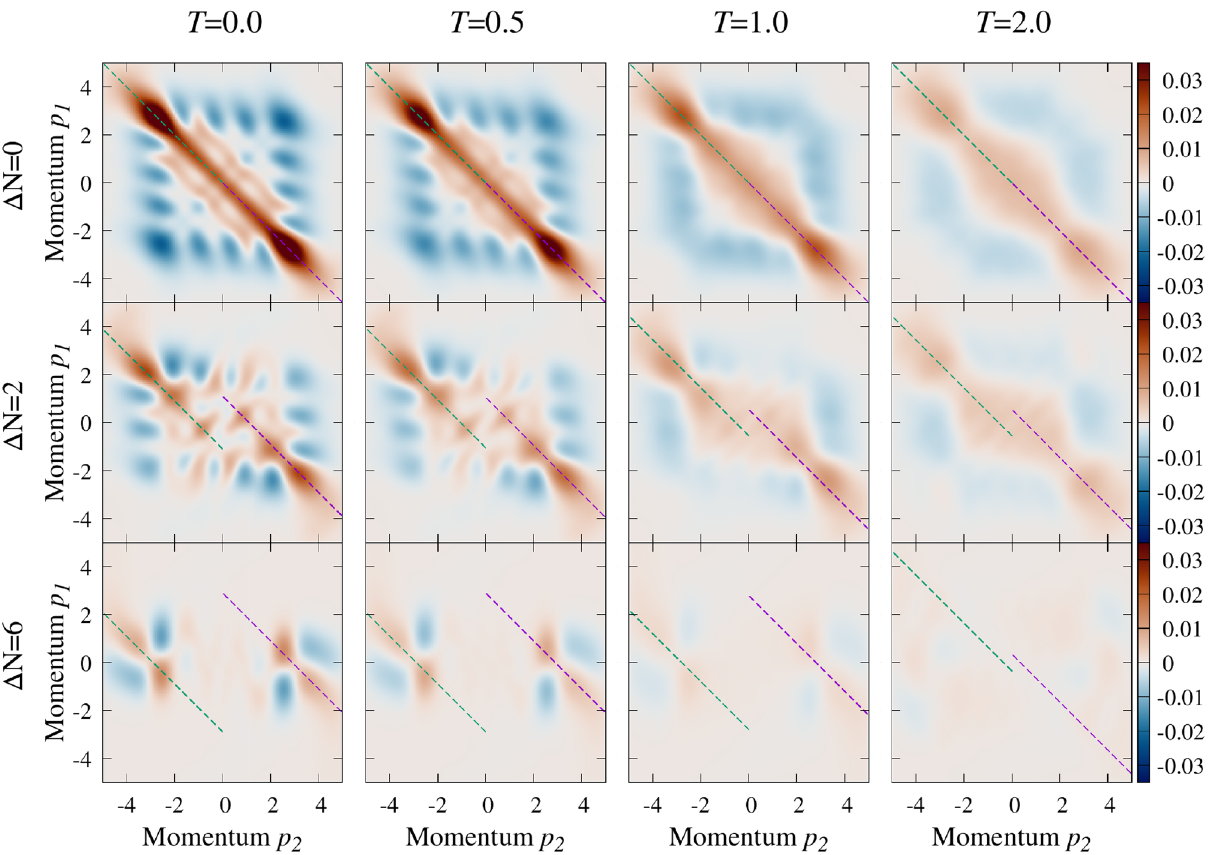
8 particles at strong attraction =